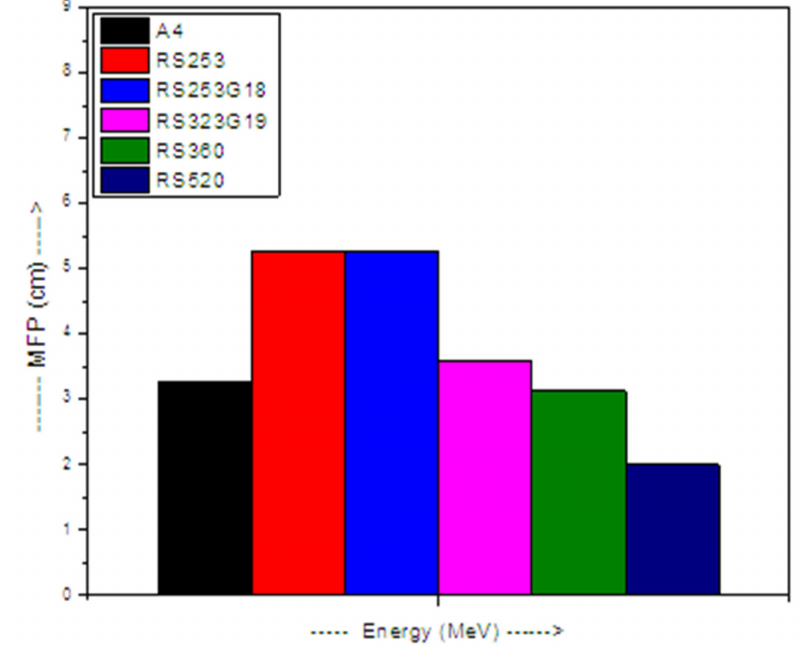
Figure 10. MFP comparison of glass A4 with commercial shielding glasses at 0.662